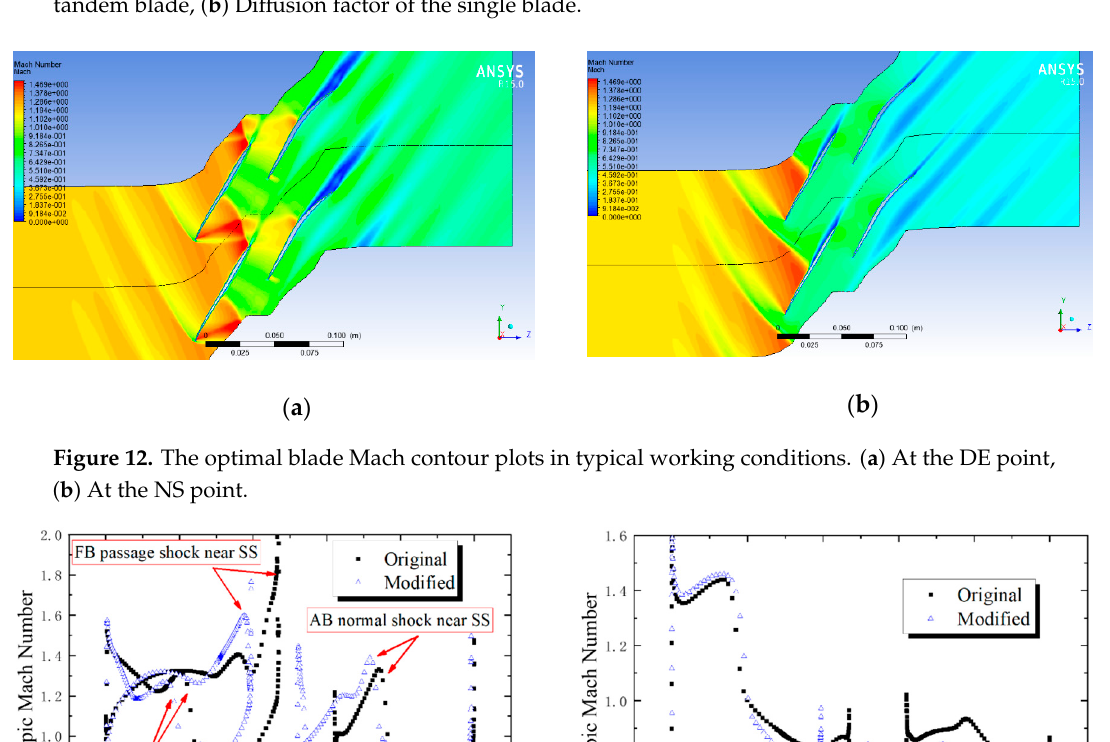
Figure 12. The optimal blade Mach contour plots in typical working conditions. ( a ) At the DE point, ( b ) At the NS point.